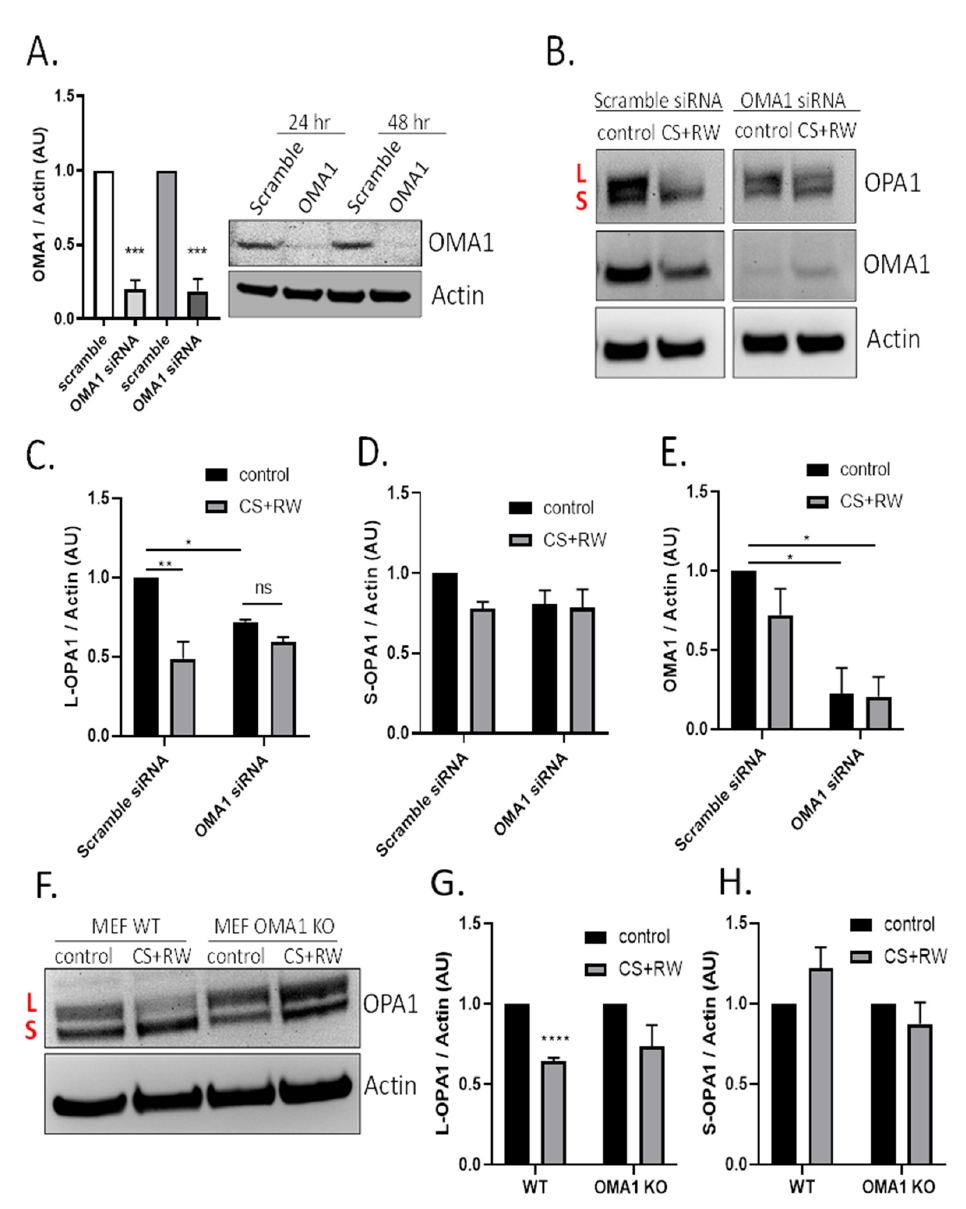
Figure 3. CS + RW induces OMA1-dependent OPA1 proteolytic processing in NRK cells. ( A ) Representative OMA1 western blots of NRK cells transfected with 50 nM of OMA1 or Scramble Scheme 80. and 79% at 24 and 48 h, respectively. ( B ) Representative OPA1, OMA1, and actin